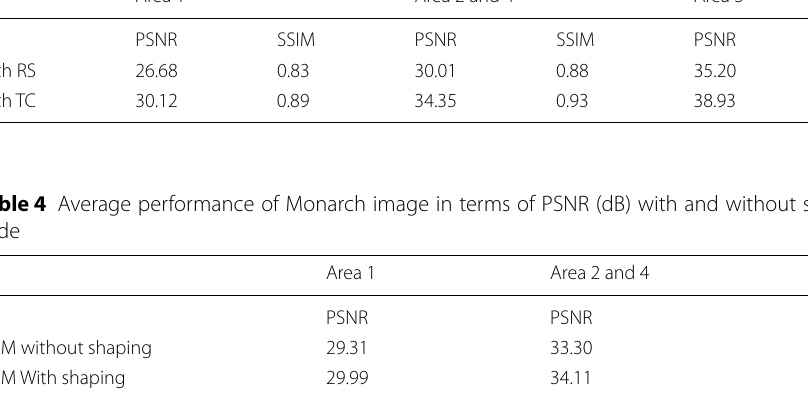
Table 3 Average performance for the Monarch image in terms of PSNR ( dB ) and SSIM Area 1